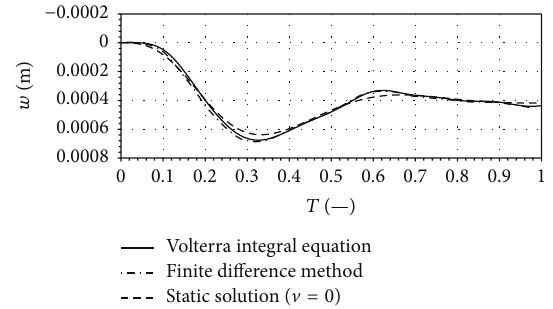
Figure 20: Dynamic deflection of point “a” due to a moving distributed